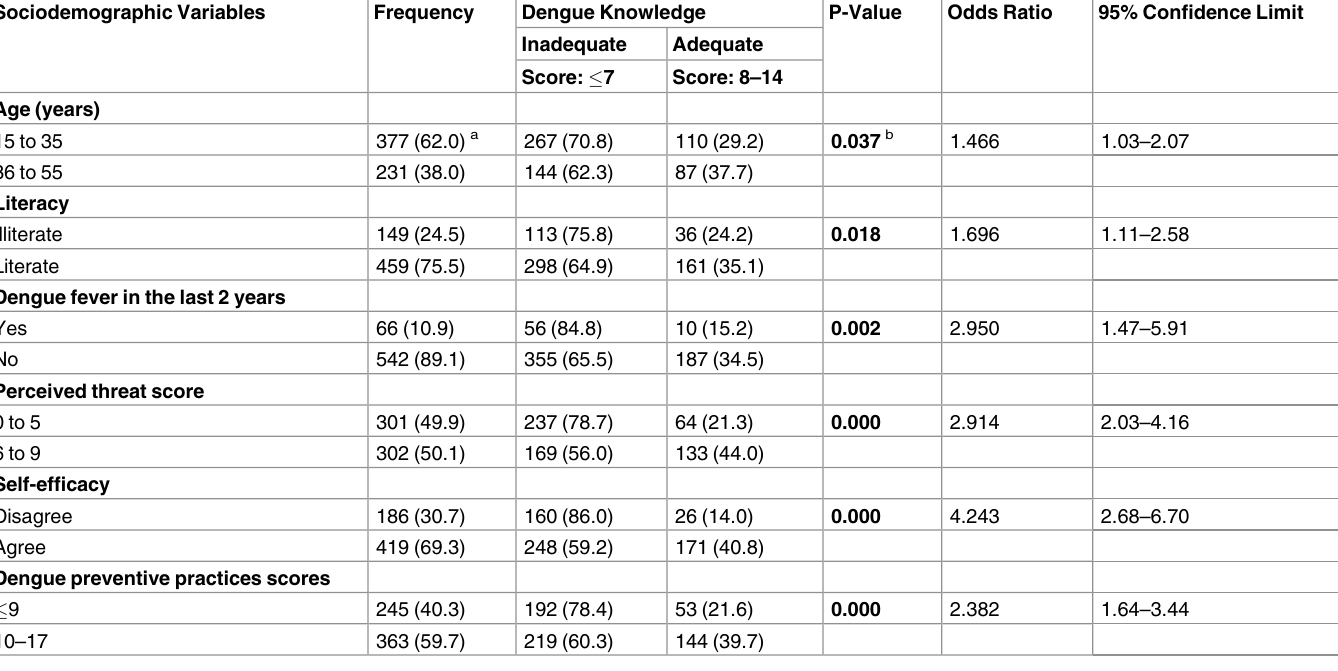
Table 2. Univariate Analysis of the Association of Knowledge about Dengue with Demographic and Other Determinants (N = 608). Sociodemographic